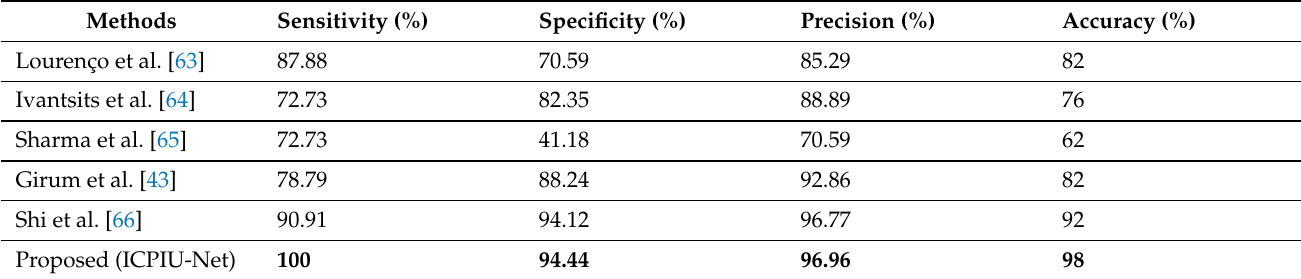
Table 7. Results of the classification contest. Best results in